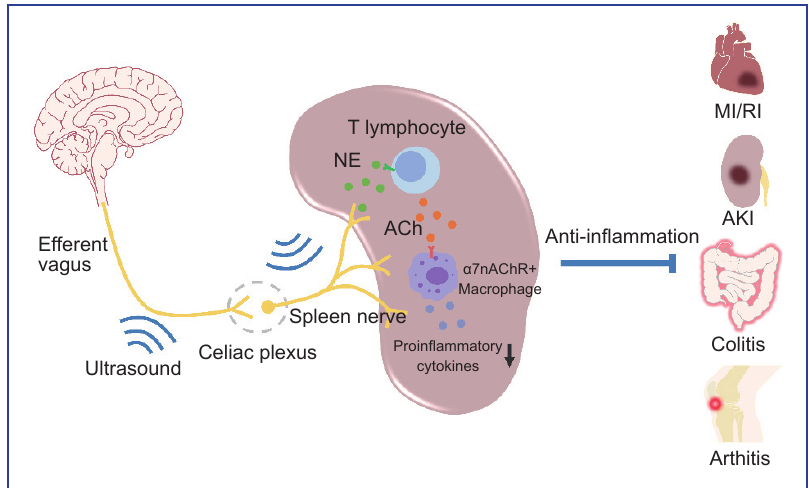
Figure 1 Ultrasound activates CAP exerting an anti-inflammatory effect in various inflammatory diseases. MI/RI, myocardial ischemia-reperfusion injury; AKI, acute kidney injury; NE,